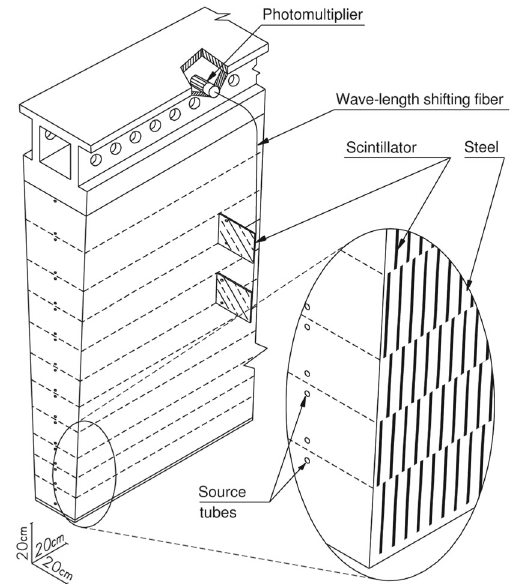
Fig. 3 Mechanical structure of a TileCal module, showing the slots in the steel for scintillating tiles and the method of light collection by wavelength-shifting fibres to PMTs. The holes for radioactive source tubes that traverse the module perpendicularly to the iron plates and scintillating tiles are also